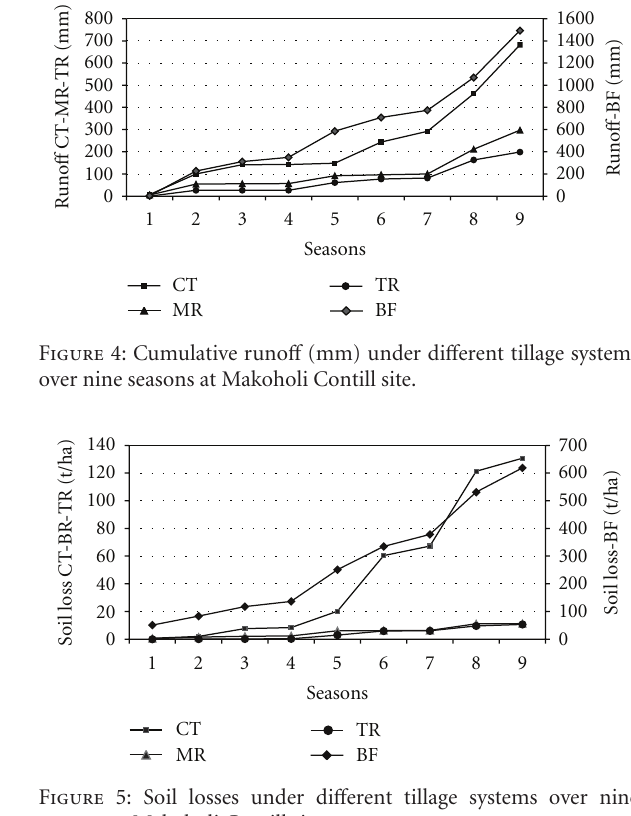
Figure 5: Soil losses under di ff erent tillage systems over nine seasons at Makoholi Contill